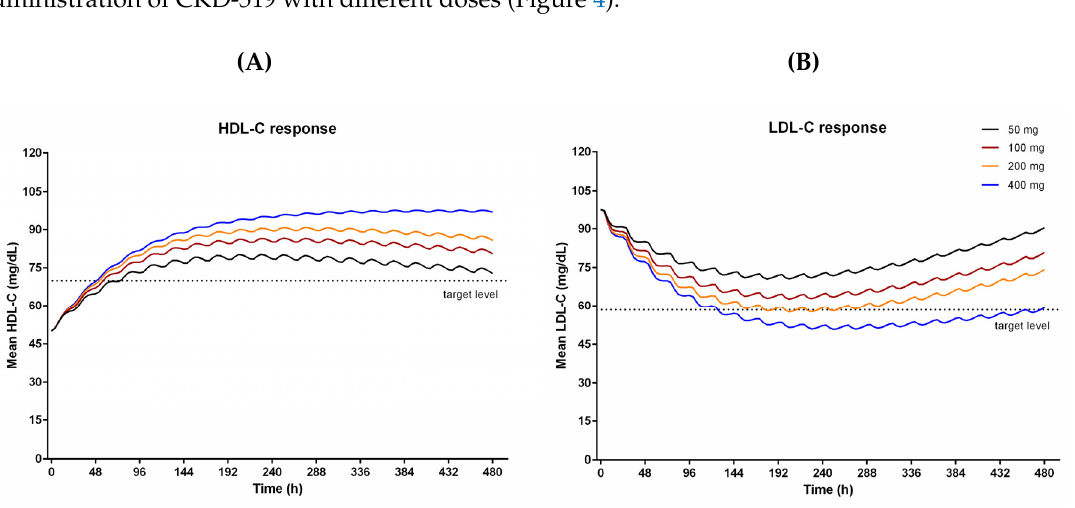
Figure 4. Simulation based assessment of the exposure-response relationship: ( A ) HDL-C response, ( B ) LDL-C response. They are simulated HDL-C and LDL-C responses after 21-day repeated administration of CKD-519. The dashed lines are the target values, which are set by a 40% change from baseline of HDL-C and LDL-C, respectively.